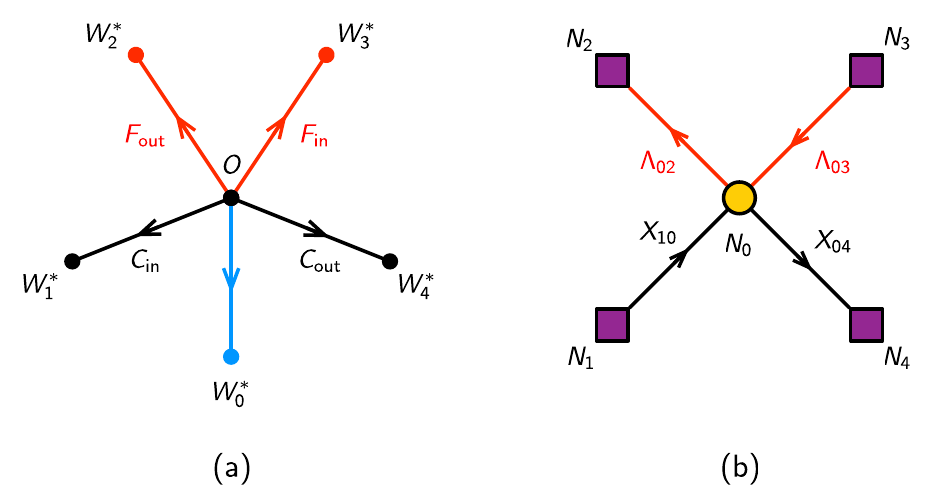
Figure 3 . (a) Con(cid:12)guration of vanishing paths on the W -plane for a CY 5 for a reference cycle associated to W (cid:3) . We indicate the type of (cid:13)avor contributed by each cycle: chiral ( C in and C out ) 0 or Fermi ( F in and F out ). (b) Corresponding quiver diagram. We refer to this theory as T